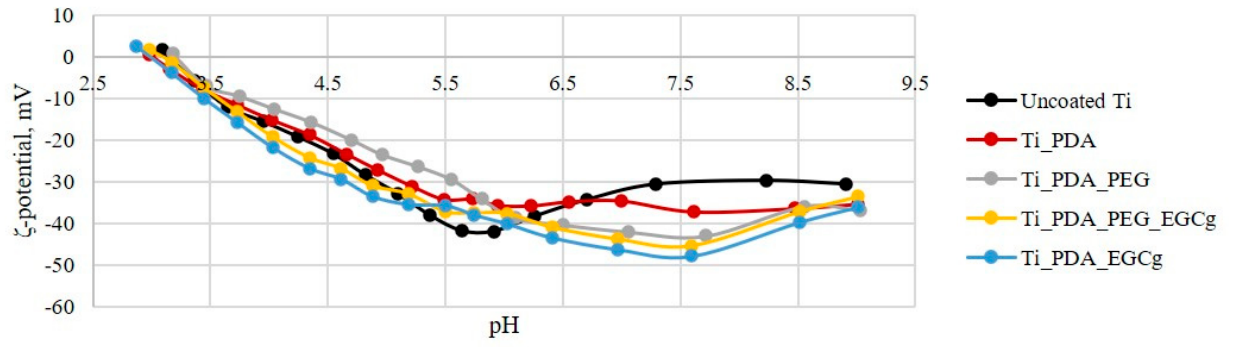
Figure 5. pH scan of Ti, Ti-PDA, Ti-PDA-aPEG, Ti-PDA-EGCg and Ti-PDA-aPEG-EGCg samples.